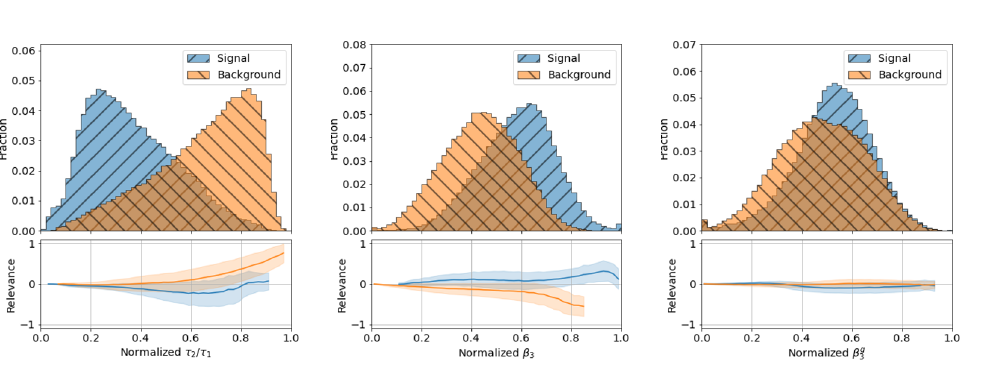
Figure 30. Histograms with profiles of normalized LRP relevances.